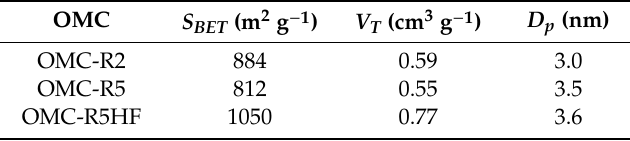
Table 1. Textural parameters of OMC supports.